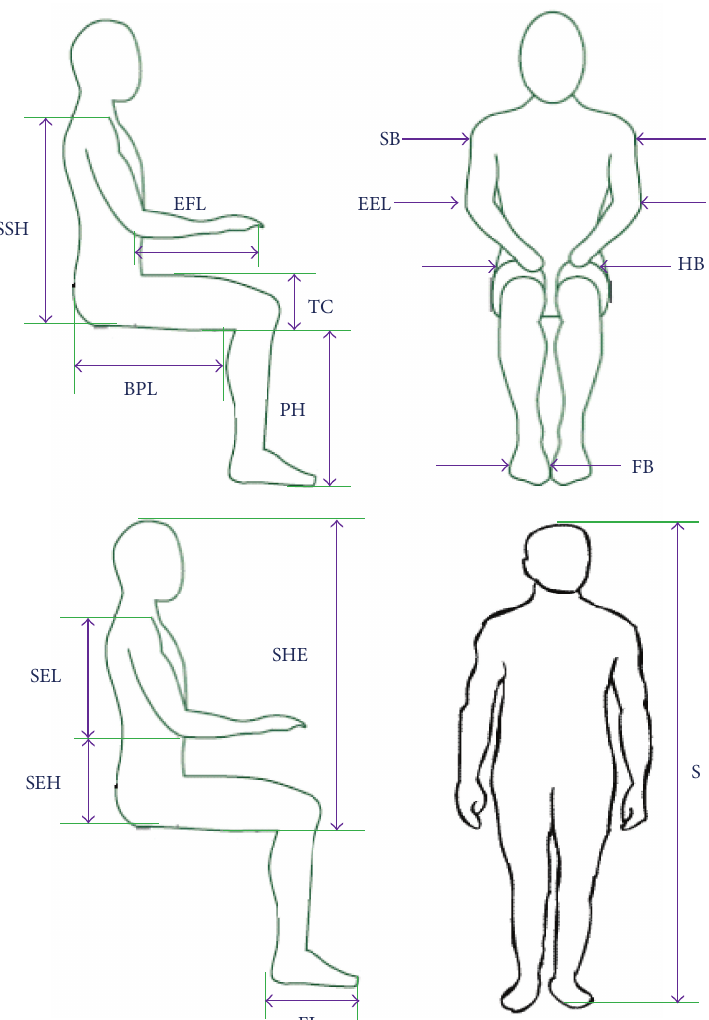
Figure 1: Anthropometric measurements of driver. PH: popliteal height, SHE: sitting height erect, SEH: sitting elbow height, TC: thigh clearance, BPL: buttock popliteal length, EEL: elbow to elbow length, HB: hip breadth, SSH: sitting shoulder height, SB: shoulder breadth, SEL: shoulder elbow length, EFL: elbow fingertip length, FB: foot breadth, FL: foot length, and S: